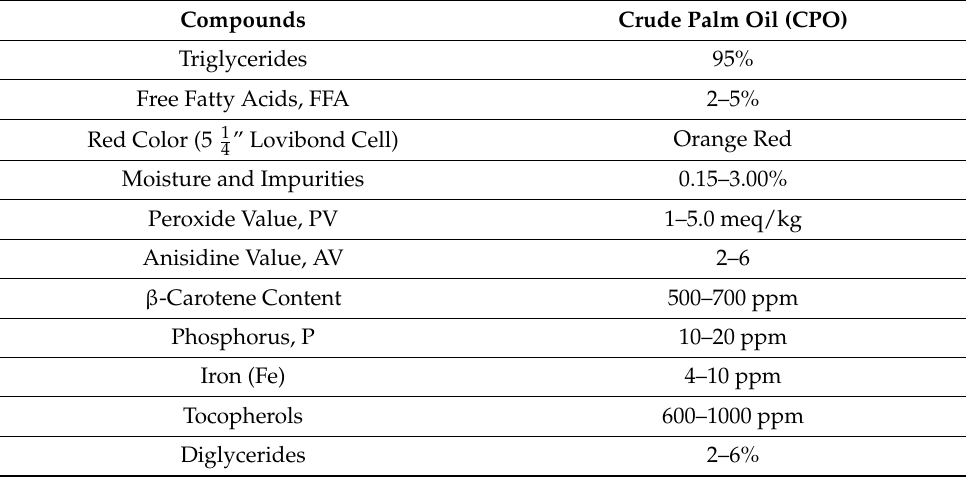
Table 2. The main compounds in Malaysian crude palm oil